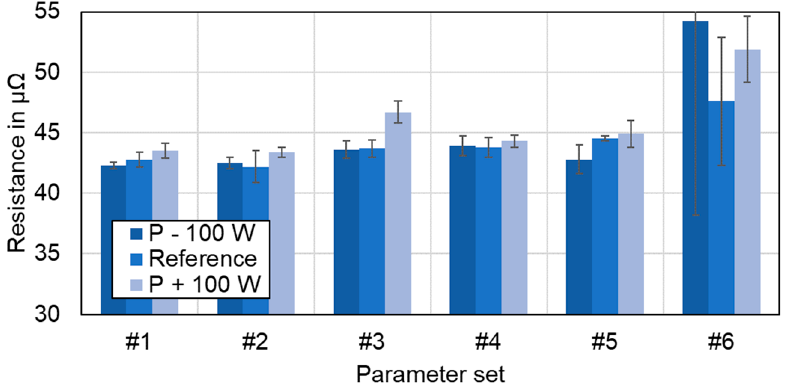
Figure 28. Comparison of electrical contact resistance measurements for parameter sets #1–#6 and variation of the laser power.